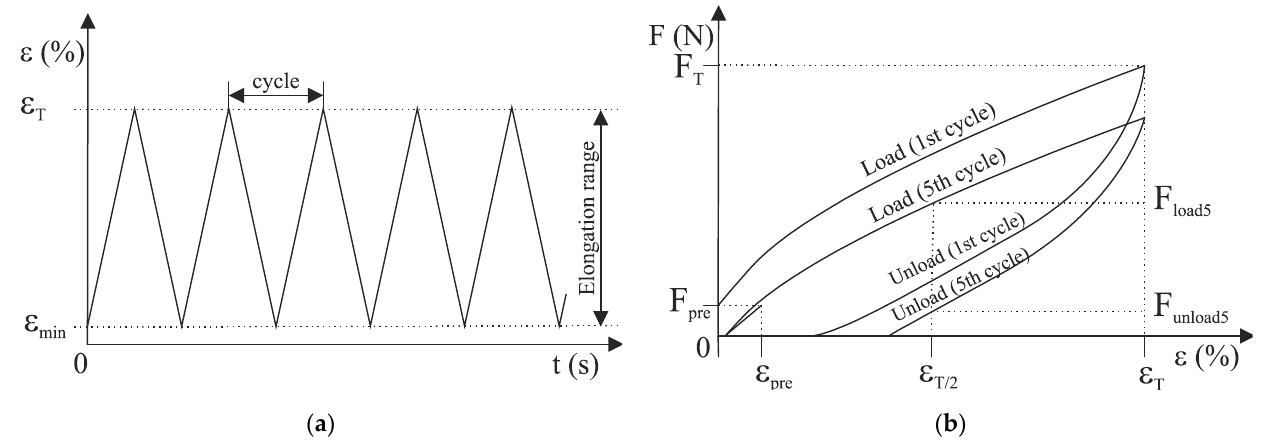
Figure 3. Cyclic testing: ( a ) schematic representation of the change in elongation over time; ( b ) loading–unloading curve.